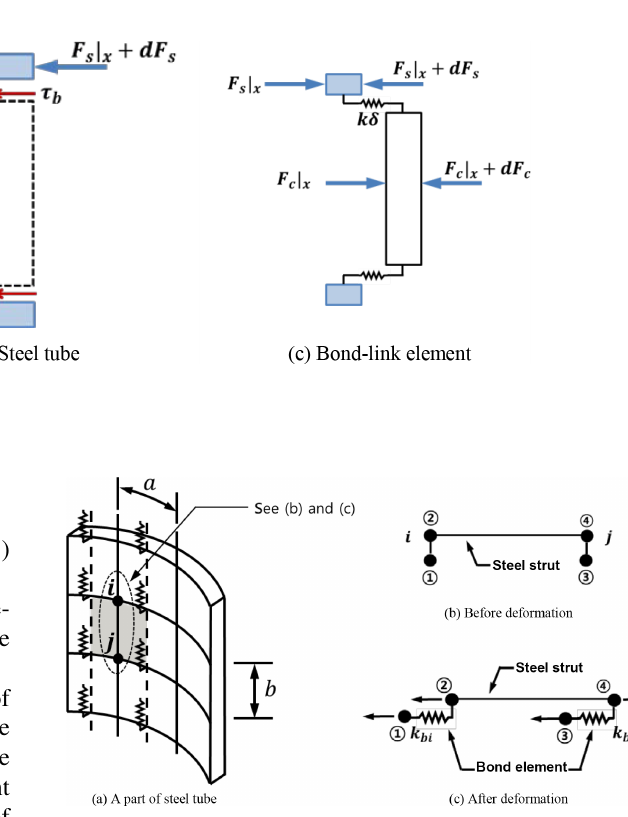
Figure 3. Stress state in a CFT column.